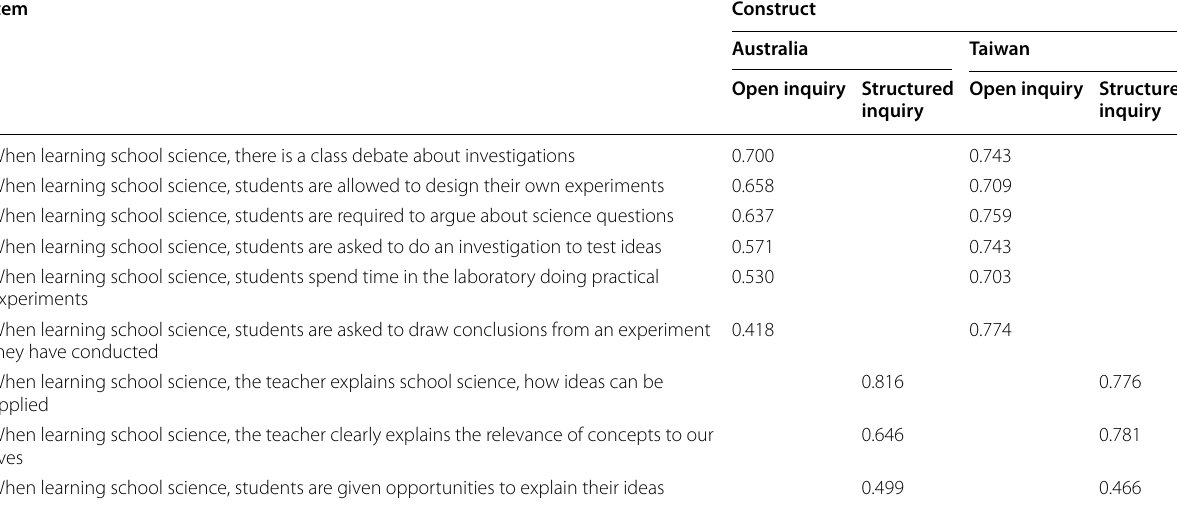
Table 1 Factor loadings for inquiry‑related learning activities based on exploratory factor analyses of Australian and Taiwanese